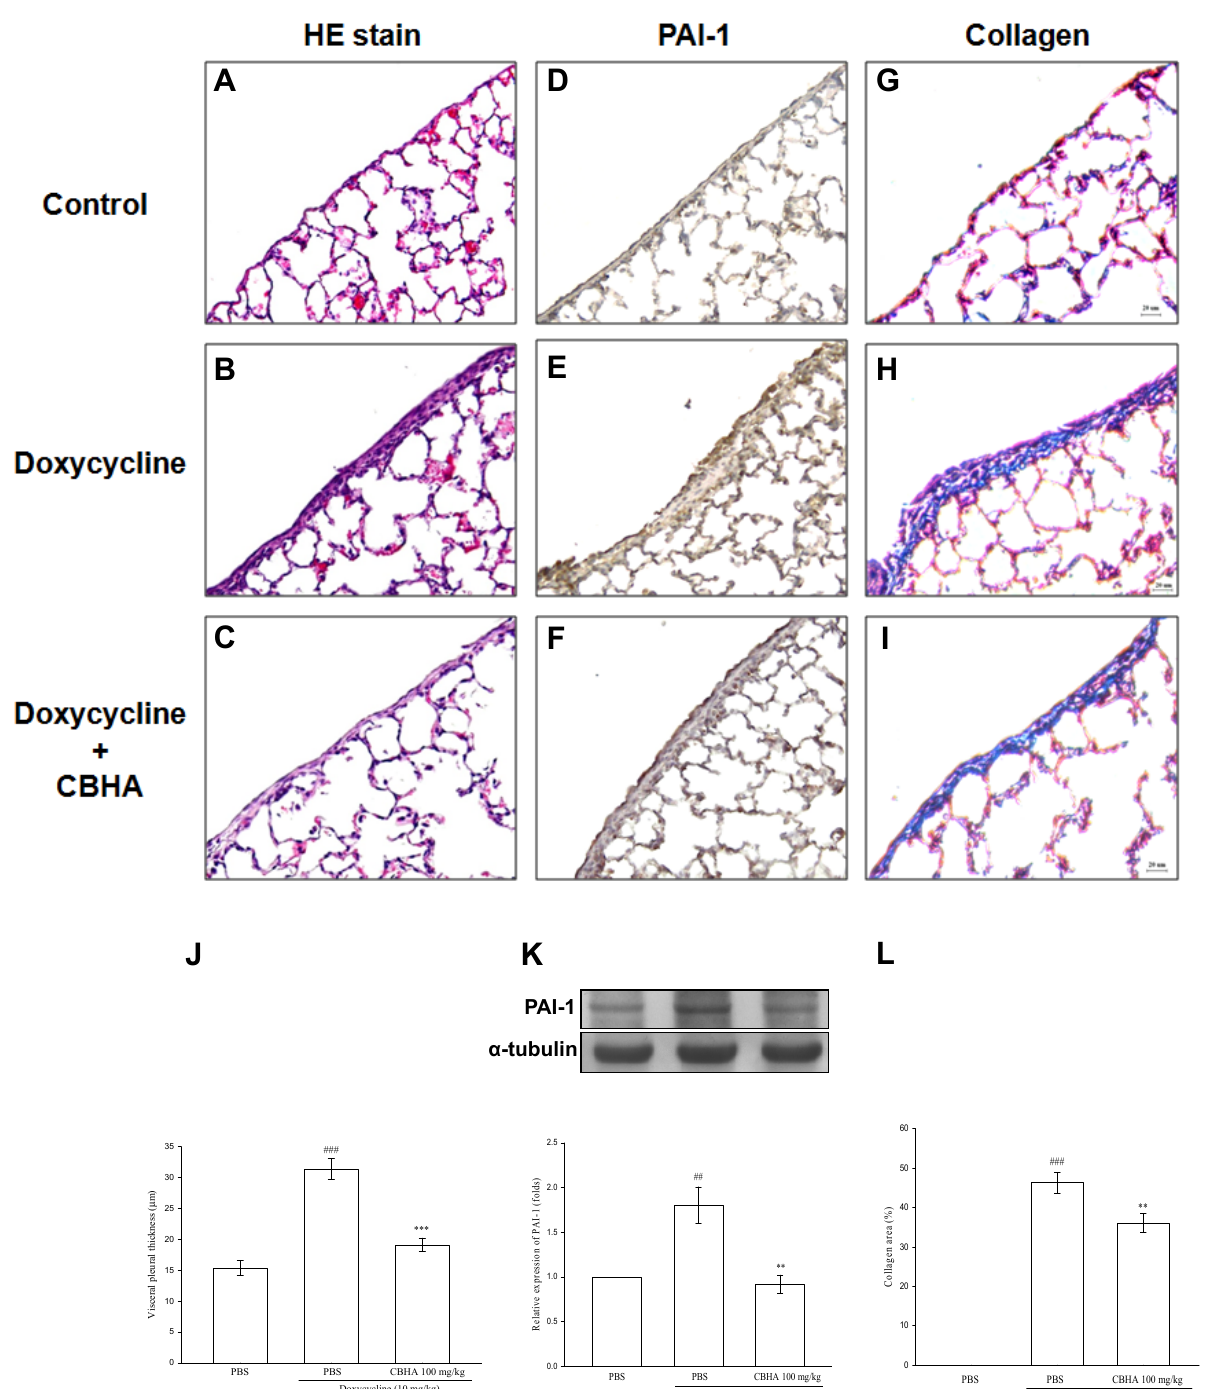
Figure 5. CBHA attenuates doxycycline-induced pleural thickening, PAI-1 expression and collagen deposition in viscera pleurae of rats. Photomicrographs of visceral pleura from haematoxylin and eosin (HE)-stained ( A – C ), PAI-1 immunostained ( D – F ) and Masson trichrome-stained (collagen, G – I ) paraffin sections of pleura tissue obtained at autopsy 7 days after intrapleural injection with PBS (control), doxycycline (10 mg/Kg) plus PBS, or doxycycline plus CBHA (100 mg/Kg). ( J ) Histomorphometric quantification of visceral pleural thickness on pleural tissue resected 7 days after intrapleural injection of indicated agents. Ten random measures per section per animal ( n = 3 for each group) were obtained. ( K ) PAI-1 expression in pleural tissue homogenates was analyzed by western blot and measured by optical densitometry analysis. Data